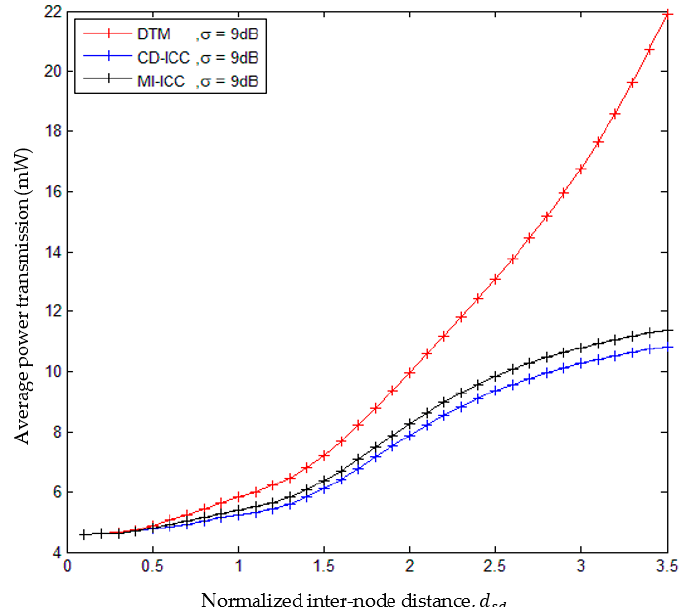
Figure 9. Comparison of average power transmission of DTM, MI-ICC and CD-ICC with normalized inter-node distance, d sd .